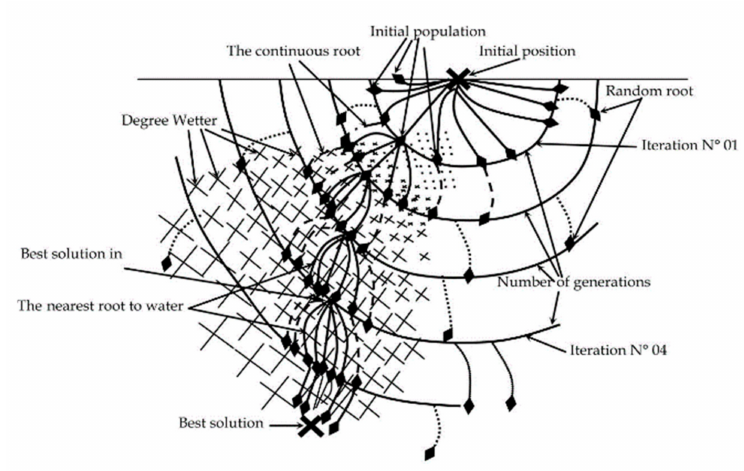
Figure 3. Searching mechanism of the RTO algorithm for searching for the water location